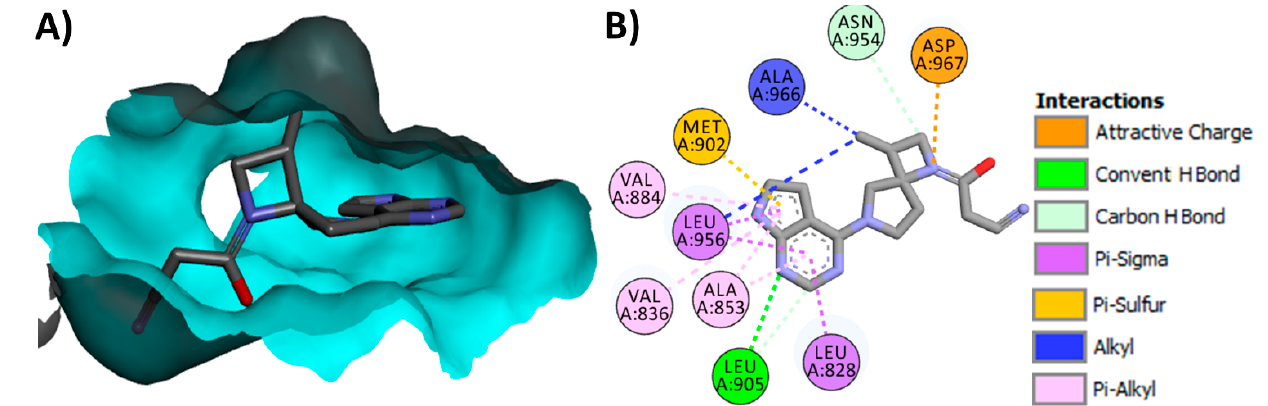
Figure 24. Binding modes of delgocitinib (shown as sticks) into JAK3 (pdb: 7C3N): ( A ) 3D binding mode, receptor shown as a hydrogen bond surface; ( B ) 2D binding mode showing different types of interactions with JAK3; this figure was generated using Discovery Studio Visualizer (V16.1.0.15350).